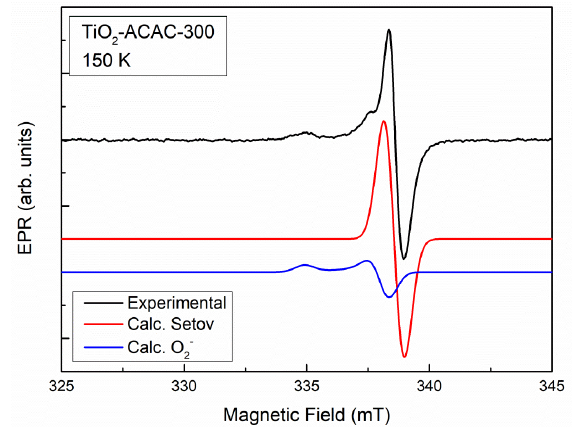
Figure 7. EPR experimental spectrum of TiO 2 -ACAC-300 at 150 K under UVA light and EPR calculated spectra of single-electron-trapped oxygen vacancies (SETOV) and superoxide anion radical at 150 K, using Easyspin